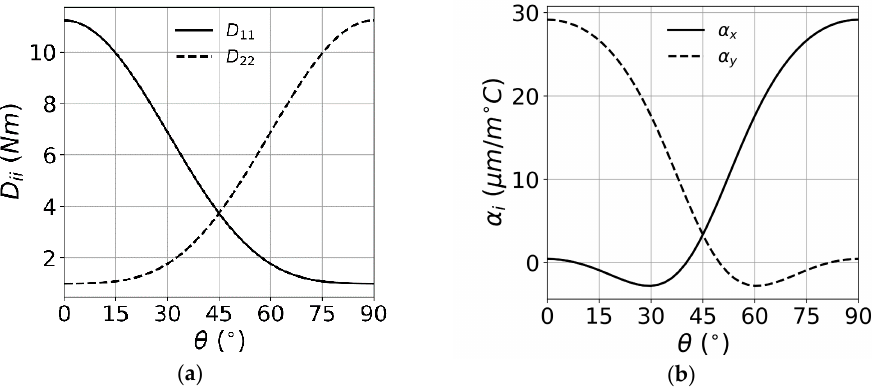
Figure 3. Properties of composite plates: ( a ) Bending stiffness for [𝜃/−𝜃] (cid:2870)(cid:3046) laminates; ( b ) CTE’s for [𝜃/−𝜃] (cid:2870)(cid:3046) laminates.